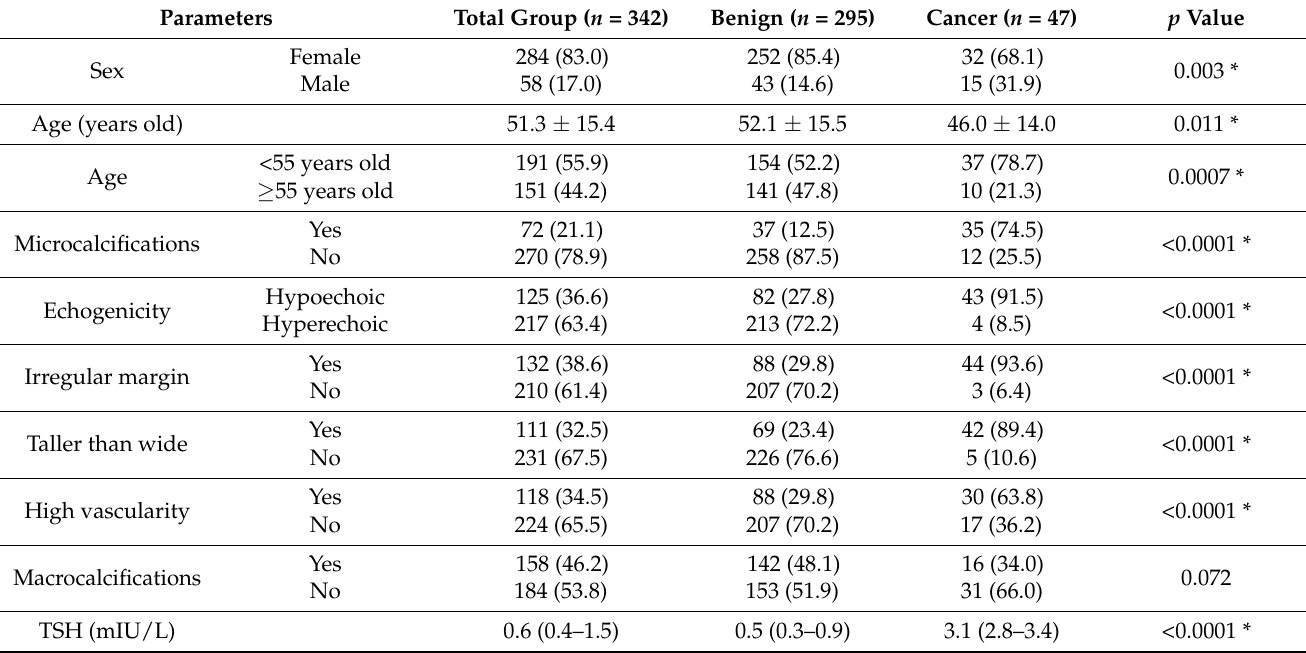
Table 2. Comparison of demographic and clinical parameters and ultrasound features between patients with histologically confirmed benign and malignant nodules. Descriptive data are presented as the number of observations (percent), mean ( ± SD) or median